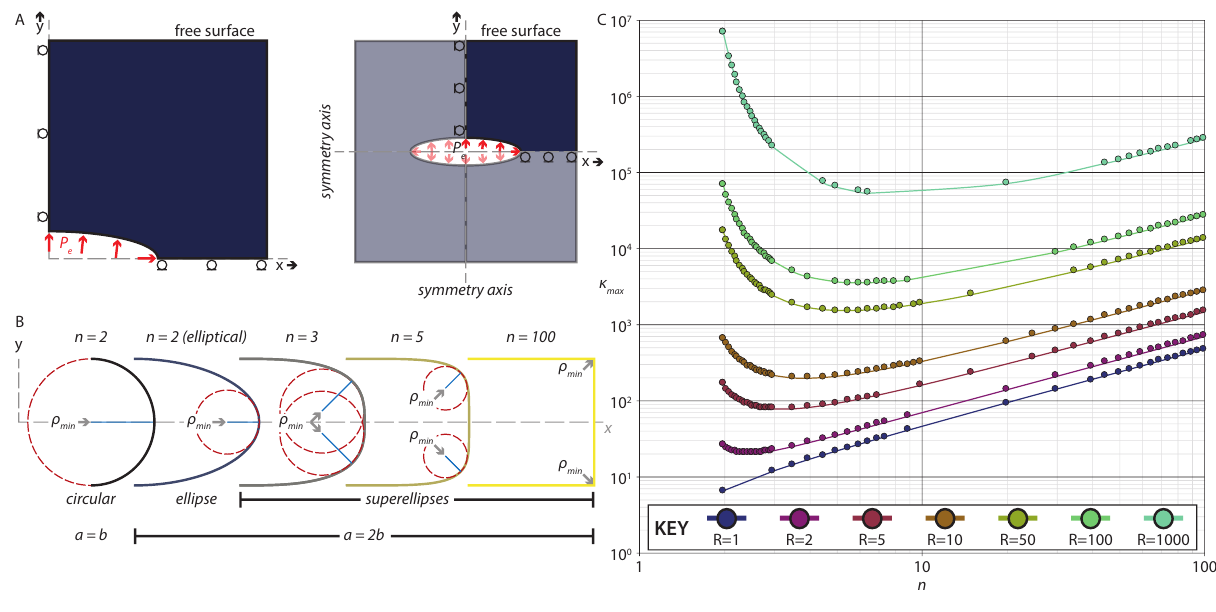
Figure 3: The 2D finite element model space. [A] Magma excess pressure P